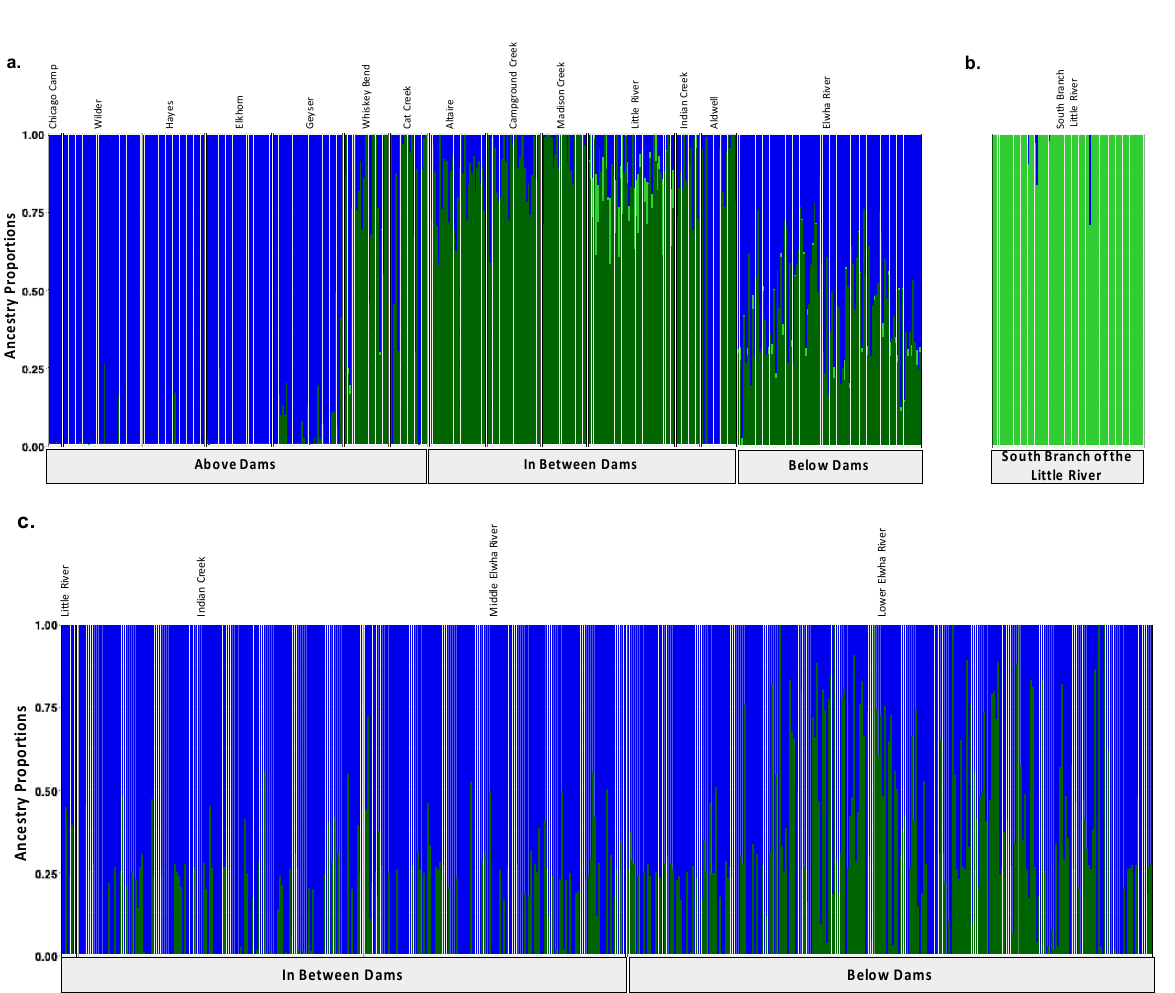
Figure 3. Population assignments computed by fastSTRUCTURE for samples collected ( a,b ) prior to dam removal supported three distinct genetic clusters (K = 3). (a) High levels of genetic structure were observed among populations split by manmade barriers such as dams ( b ) as well as natural barrier like the falls that separate the South Branch of the Little River from the Little River. ( c ) Post-dam removal, we detected two genetic clusters with increasing levels of admixture. Each vertical bar represents a single individual sampled at one of the sampling sites labelled across the top x axis which are organized from up-river to down river and divided by anadromous barrier location which are labelled on the bottom x axis. Each color represents a distinct genetic cluster.